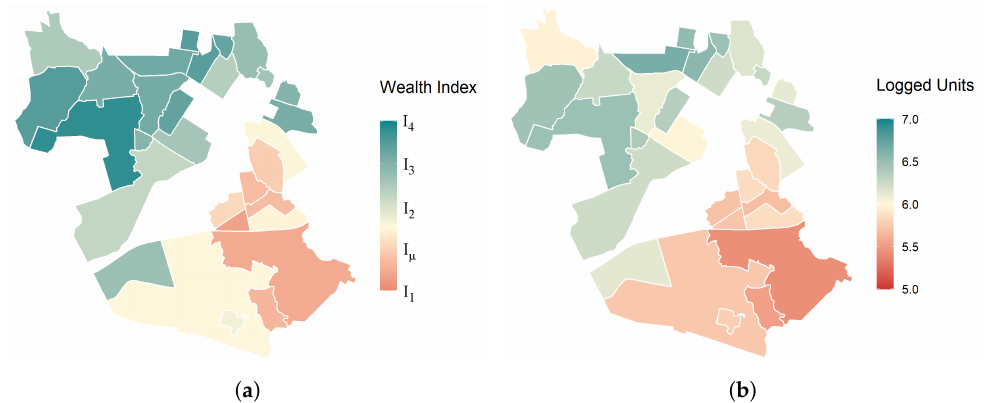
Figure 3. Map of George that compares ( a ) the distribution of wealth groups in various neighbour- hoods, where I µ indicates the average household income of South Africa, and ( b ) the average logged units purchased per month for the corresponding neighbourhoods. The blank space represents “no data”.